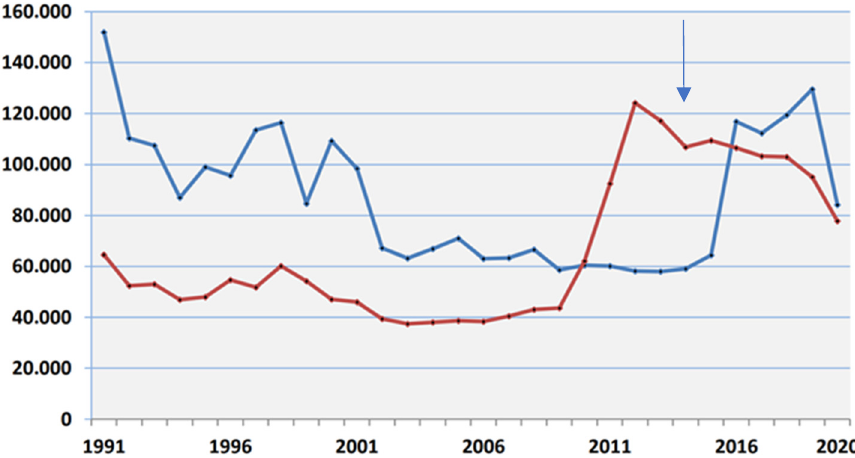
Figure 1. Components of migration balance in Greece, 1991–2020 (number of registered newcomers: blue; people expatriated and cancelled from population register: red); the arrow indicates the time period with a negative migration balance (source: ELSTAT demographic register).